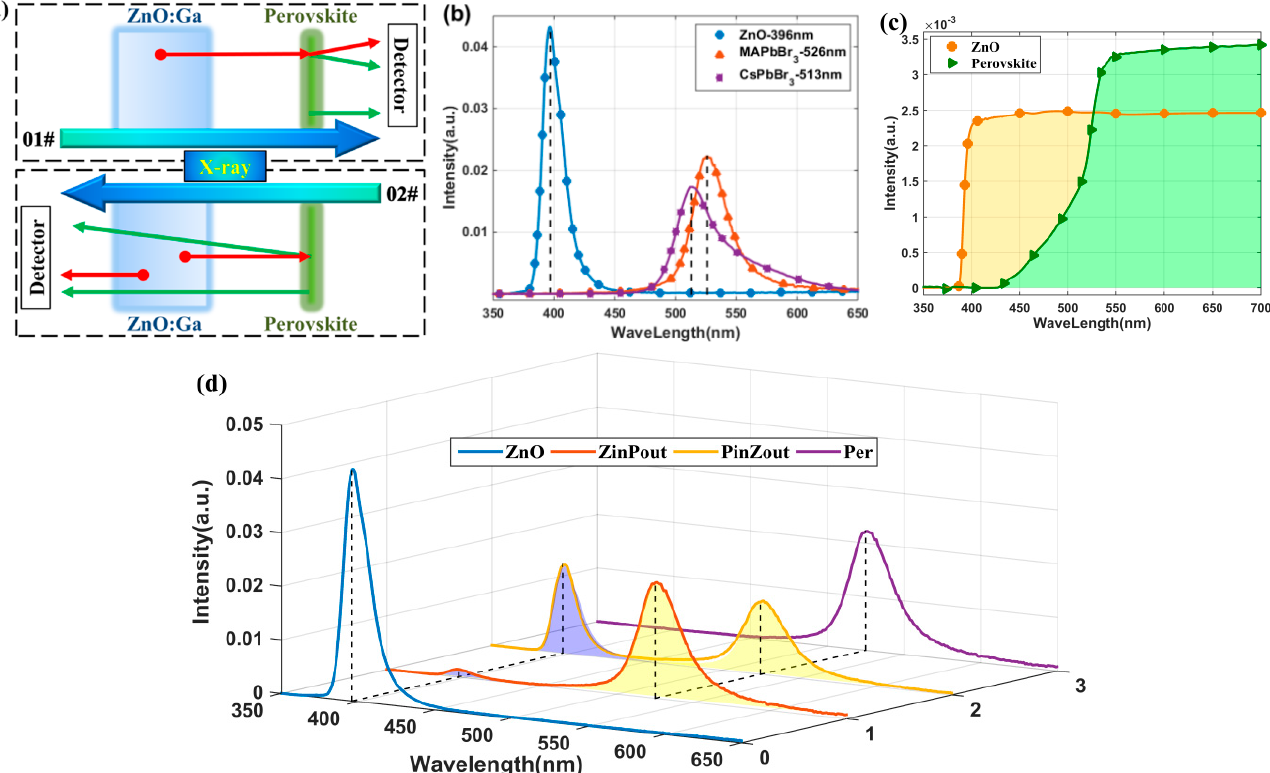
Figure 3. Luminescence properties of GZO, the perovskite, and the two-layer composite scintillator: ( a ) working principles of two-layer composite samples; ( b ) RL spectra of GZO and PL spectra of perovskite films; ( c ) transmission spectra of samples; ( d ) RL curves of composite samples and their fitting.